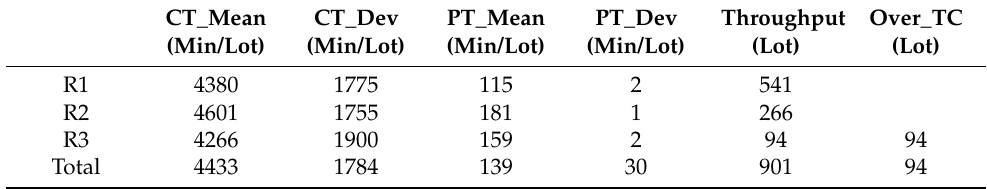
Table 6. Performance of FIFO model without taking TC into